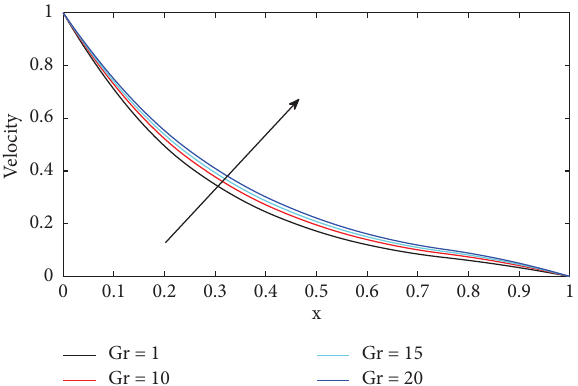
Figure 3: Velocity profles for diferent values of Gr .